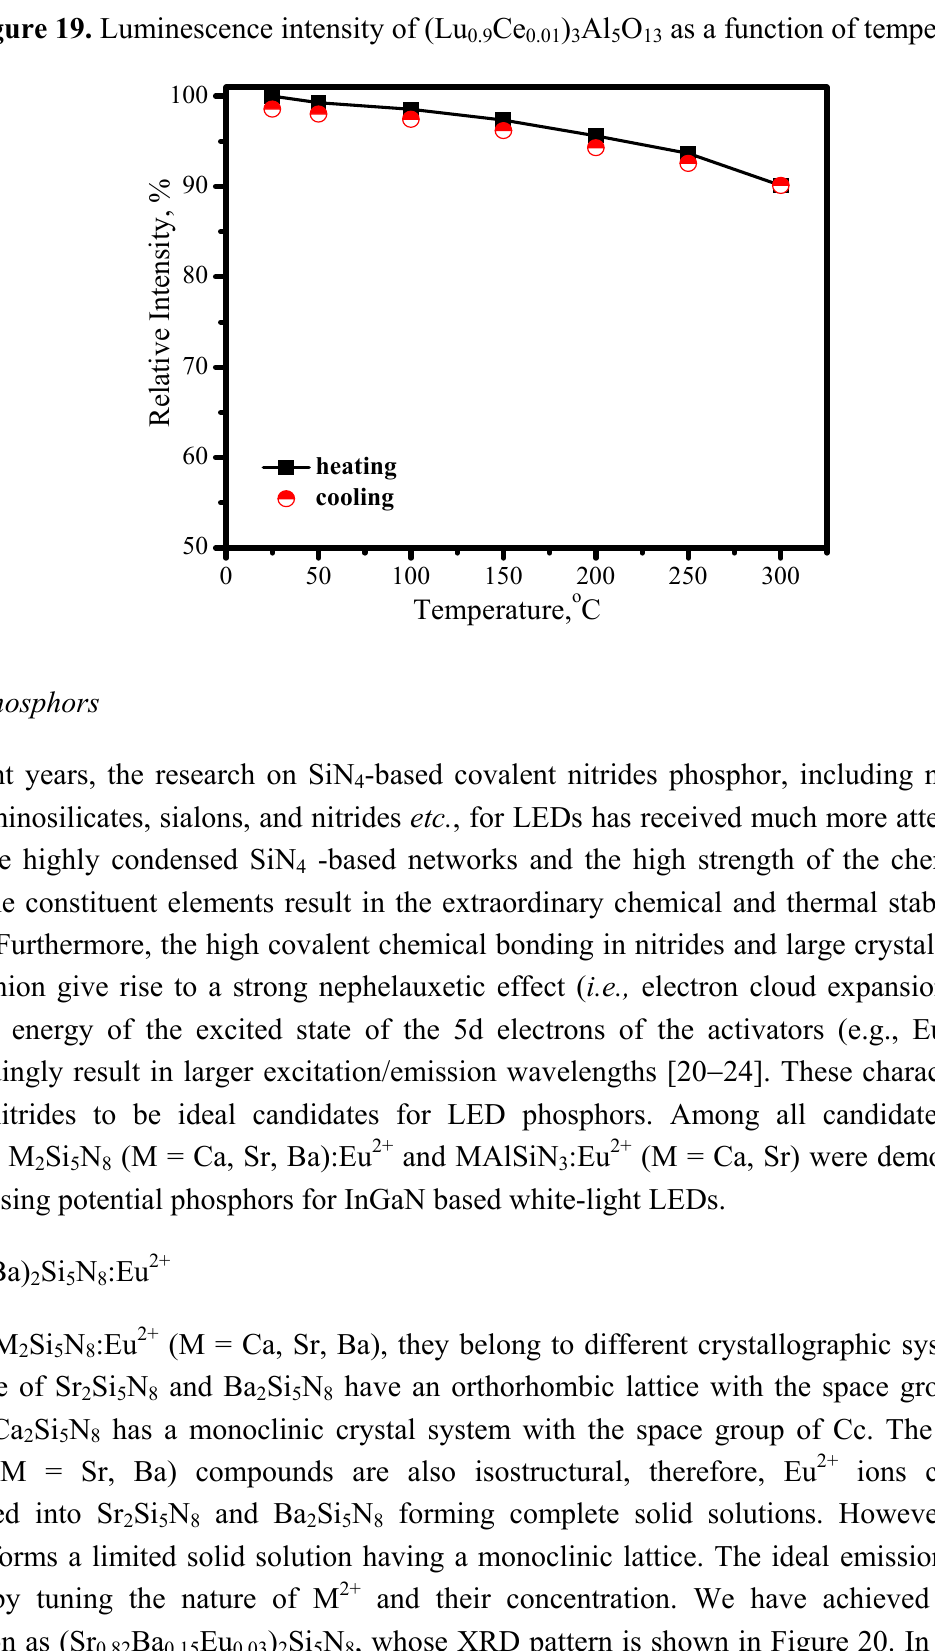
Figure 19. Luminescence intensity of (Lu